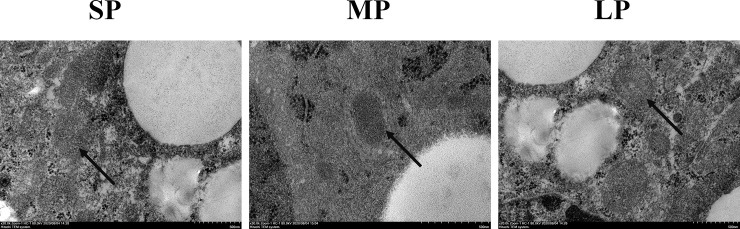
Ultrastructure of mitochondrion of HG in hamsters from three photoperiodic groups.Cristae of mitochondria of HG in hamsters from three photoperiodic groups. There were no significant different in mitochondrial morphology among three groups. There were no significant different in mitochondrial morphology and the CSA of mitochondrial among three groups Scale bar = 500nm. SP, short photoperiod; MP, moderate photoperiod; LP, long photoperiod.